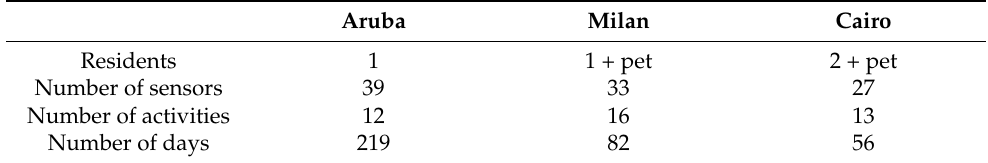
Table 1. Datasets details.